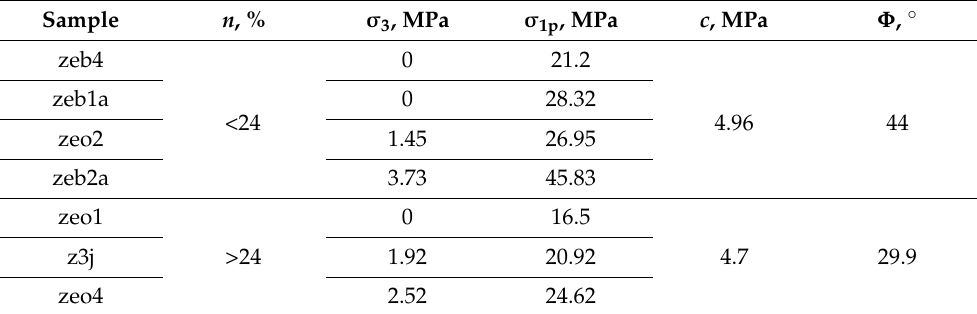
Figure 9. The relation between elastic modulus (E) and porosity ( n ) of the zeolite-bearing rocks. Table 7. Compressive strength of the zeolite-bearing